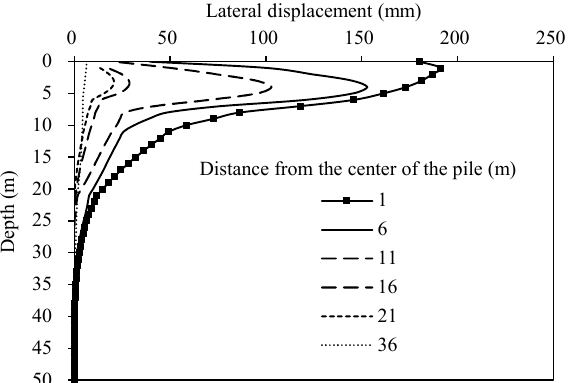
Figure 9. The lateral displacement of the foundation soil after the 5th loading.